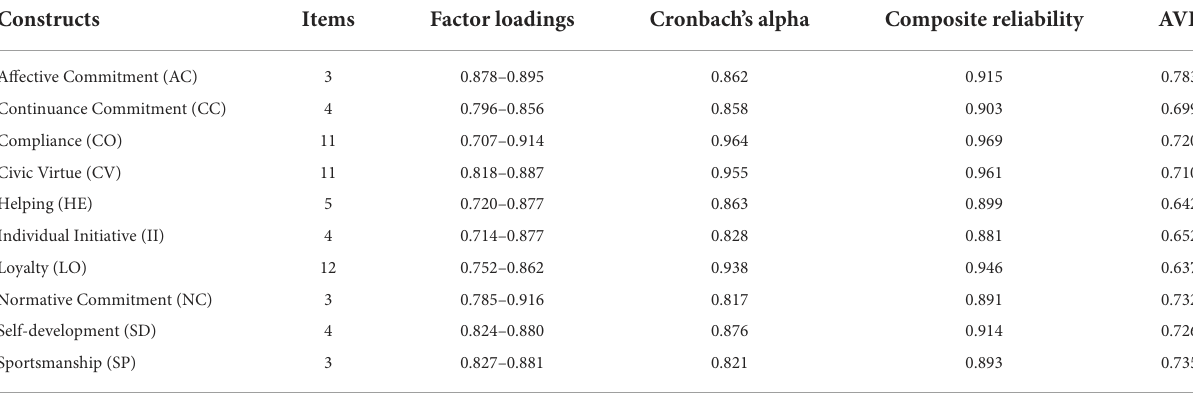
TABLE 2 Factor loadings and composite reliability of the measurement model.